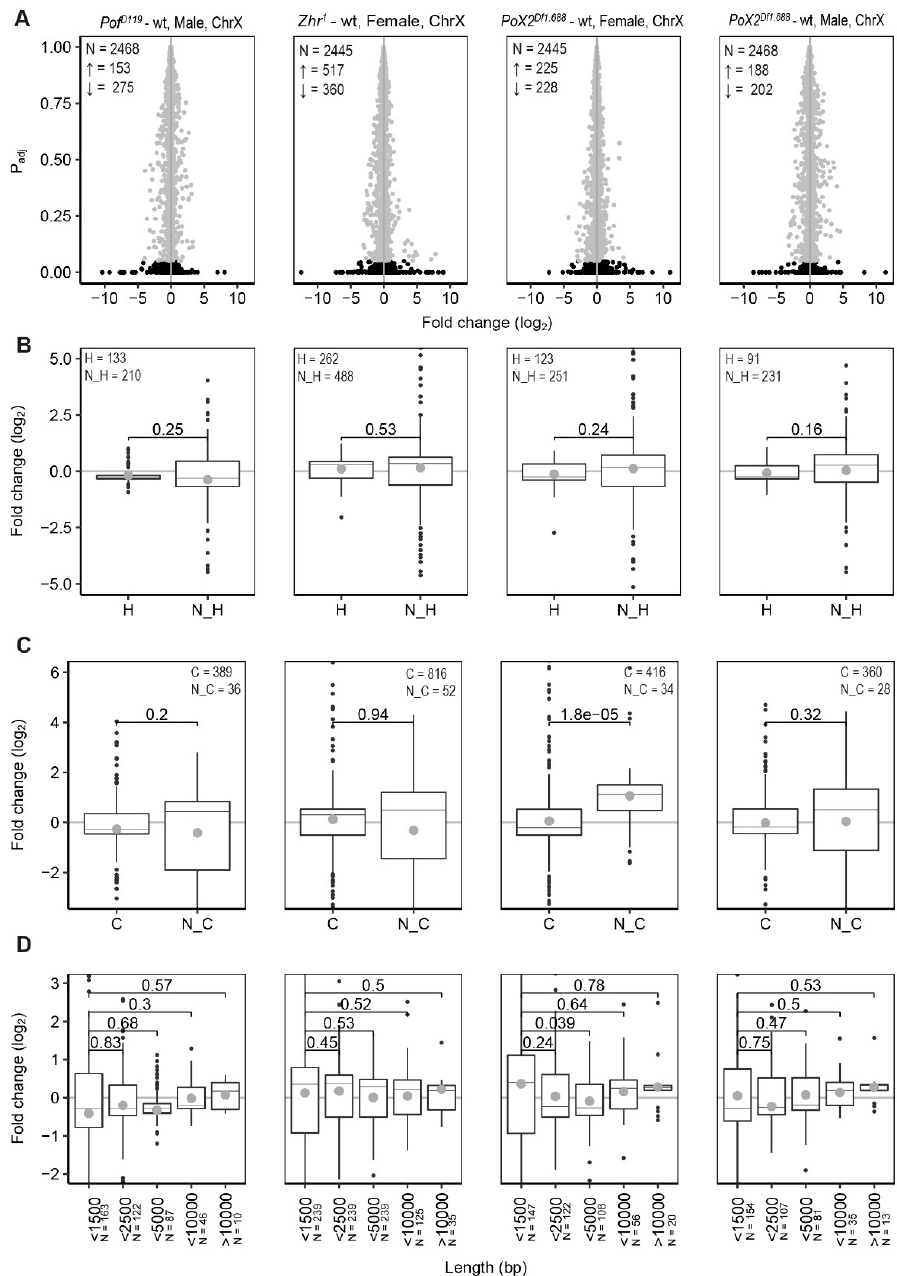
Figure 3. Feature analysis of significant di ff erentially expressed genes on the X-chromosome. ( A ) Di ff erentially expressed genes on the X-chromosome. N indicates the number of all genes, ↑ indicates the number of significant upregulated genes and ↓ indicates the number of significant downregulated genes. The grey dots refer to the non-significant changes ( P adj > 0.05) and black dots indicate significant changes ( P adj < 0.05). ( B ) Comparison of expression ratios of housekeeping (H) and non-housekeeping (N_H) genes. ( C ) Comparison of expression ratios of coding (C) and non-coding genes (N_C). ( D ) Comparison of expression ratios with genes binned according to transcript length (bp) in which the binned transcript lengths represent the ranges 0–1500, 1500–2500, 2500–5000, 5000–10,000, and > 10,000 bp, respectively. Only significant altered genes ( P adj < 0.05) were included in ( B – D ). The box plots display median (line), average (dot), first and third quartiles (box), highest / lowest values within 1.5 × interquartile range (whiskers), and outliers. The statistical significance was determined by the Wilcoxon signed-rank test and p-values are